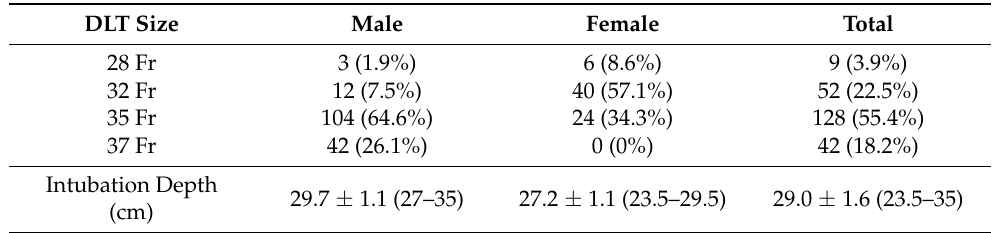
Table 3. Intubation Data. Values are given as number (%) and mean ± standard deviation (min- imum–maximum).